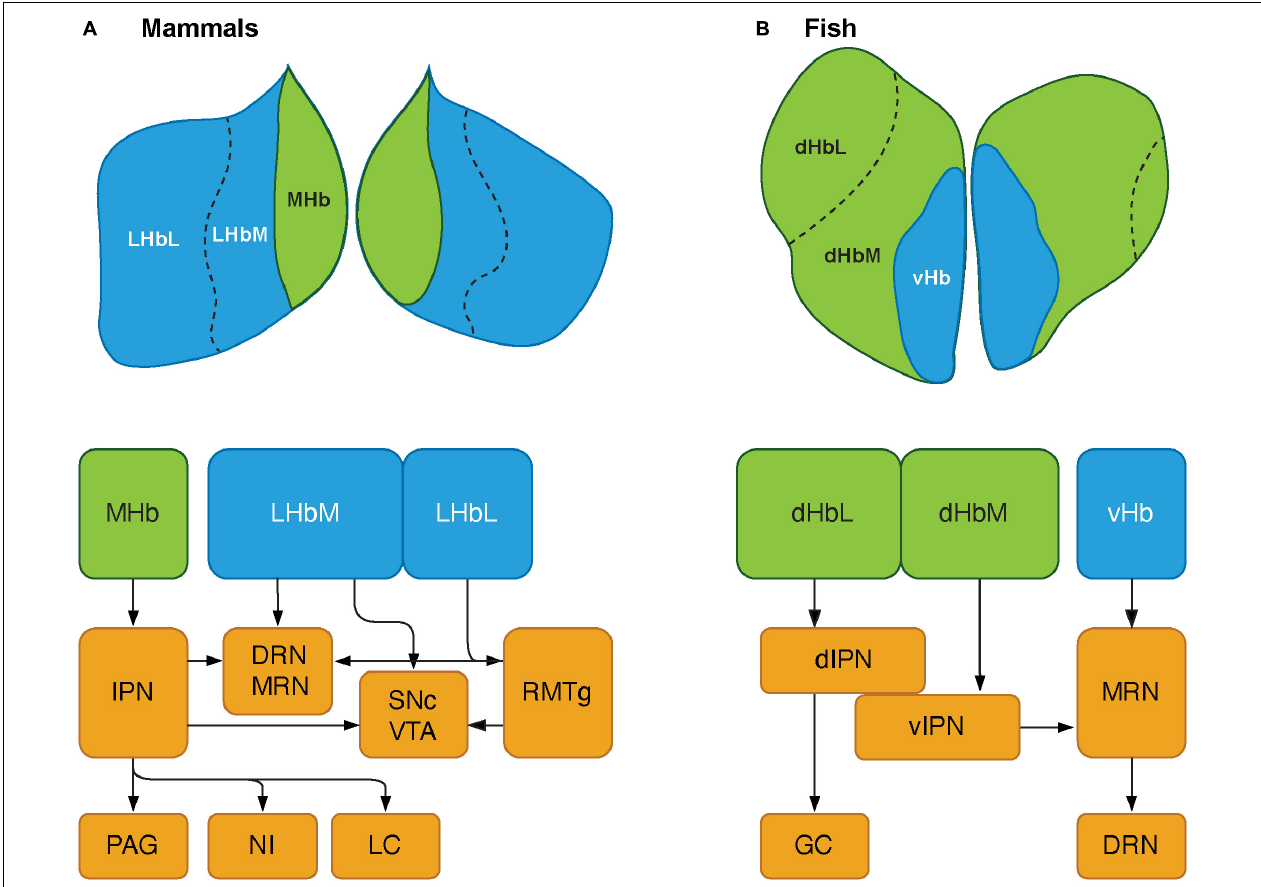
FIGURE 2 | Schematics showing the habenular pathways in mammals and teleosts. (A) The habenula consists of two major subnuclei, medial habenula (MHb) and lateral habenula (LHb) in mammals. LHb can be further divided into medial (LHbM) and lateral (LHbL) parts. MHb primarily projects to serotonergic center: the dorsal and median raphe nuclei (DRN and MRN), and dopaminergic center: substantia nigra pars compacta (SNc) and ventral tegmental area (VTA) via the interpeduncular nucleus (IPN). The MHb also sends projections to other brain regions such as the periaqueductal gray (PAG), nucleus incertus (NI), and locus coeruleus (LC). LHb projects serotonergic raphe nuclei and midbrain dopaminergic center. However, LHbL act on serotonergic and dopaminergic centers via the rostromedial tegmental nucleus (RMTg, which is also known as tail of the VTA). (B) In teleosts, the habenula structure consists of two subnuclei: dorsal habenula (dHb) and ventral habenula (vHb), which are structurally and biochemically homologous to mammalian MHb and LHb, respectively. dHb and their pathways are structurally asymmetric, hence they can be considered subnuclei: lateral (left) and medial (right) dHb (dHbL and dHbM). dHbL and dHbM project to the different regions of IPNs: dorsal (dIPN) and ventral (vIPN) part of the IPN, respectively. dIPN further innervates to the griseum centrale (GC, a homolog of the mammalian PAG), while vIPN is connected to the MRN. vHb sends projection to the ventro-anterior corner of the MRN, which may further extend toward the serotonergic DRN. Modified from Ogawa et al.